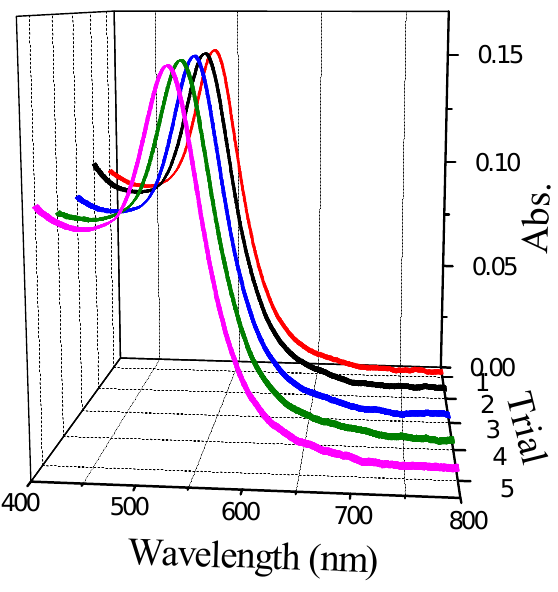
Figure 5. Comparison of the absorption spectra of the Au NP assembled films at different